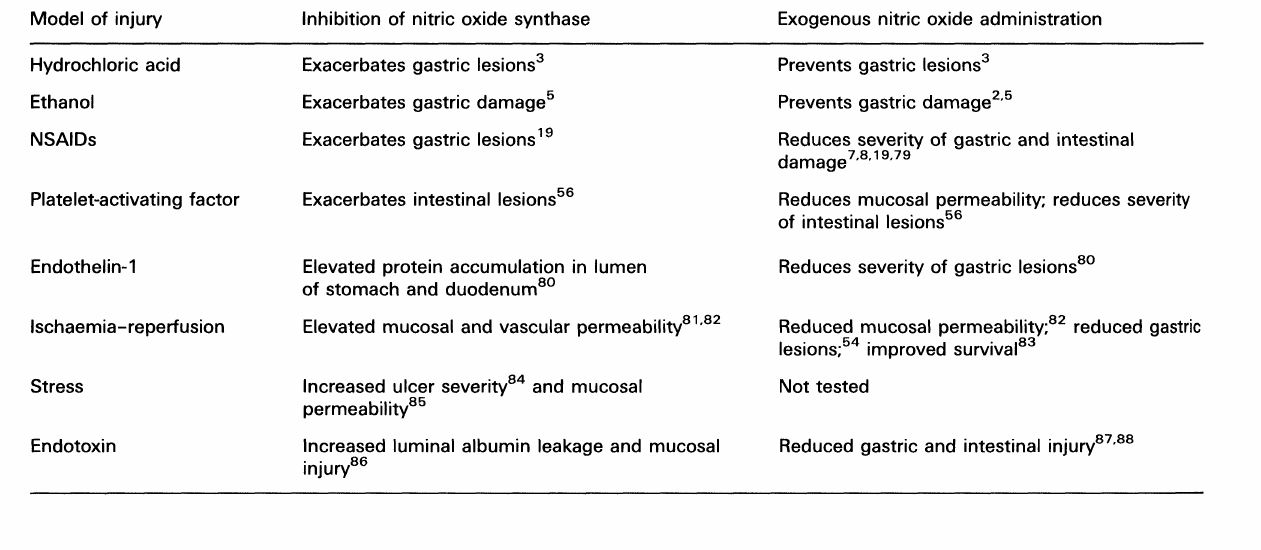
Table 1. Effects of inhibition of nitric oxide synthase or administration of nitric oxide donors in models of gastrointestinal